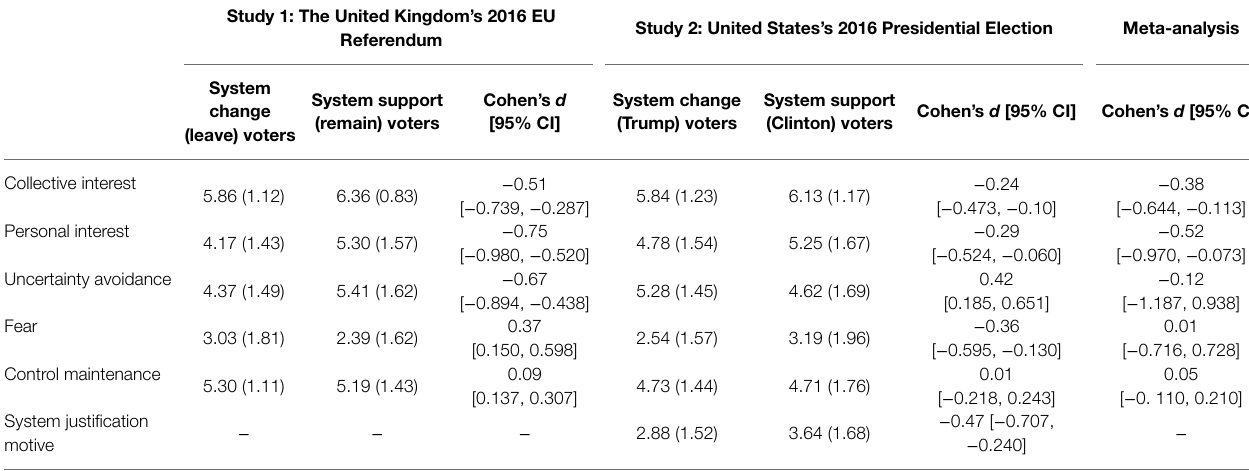
TABLE 2 | Reasons for System Support vs. System Change.